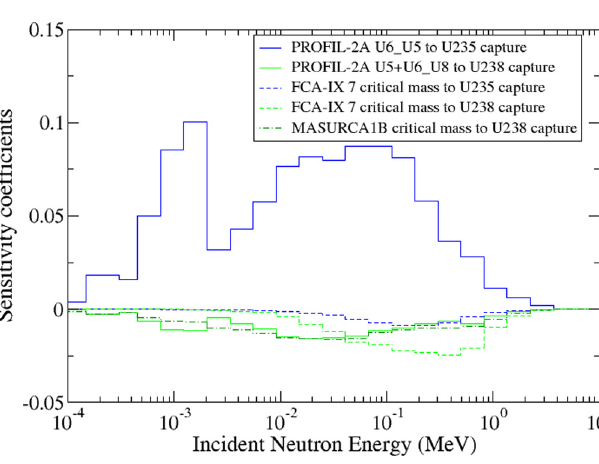
Fig. 11. Comparison of sensitivity pro fi les of PROFIL-2A C/E, and FCA-IX 7 and MASURCA 1B critical masses to 235 U and 238 U capture.